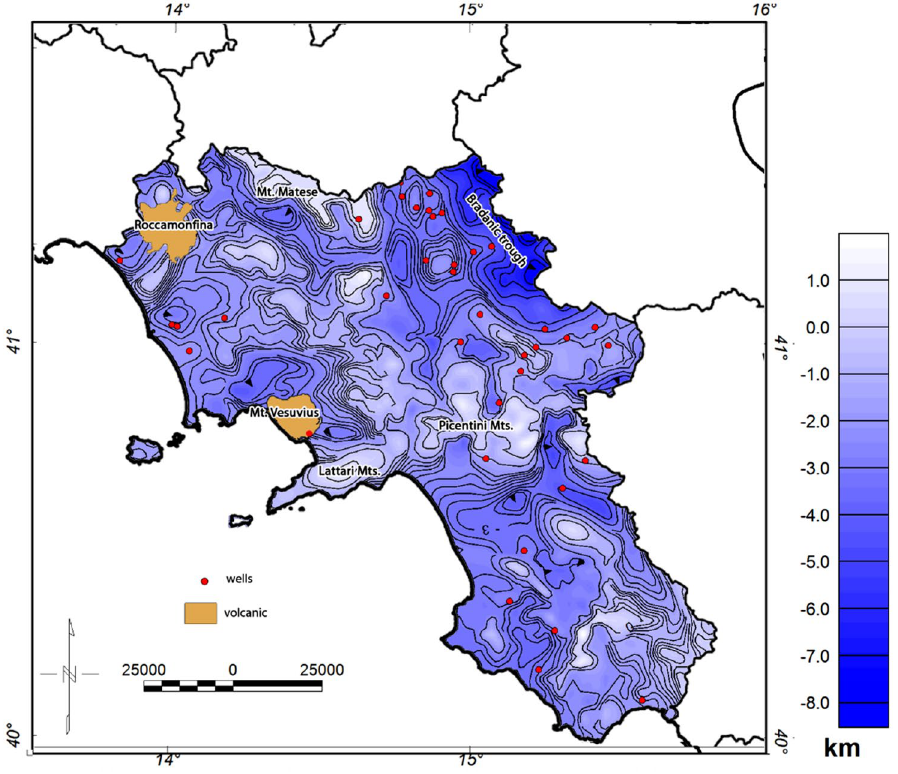
Figure 5. Model of the Mesozoic carbonate top of the Campania region obtained by the inversion of free-air and Bouguer gravity data.